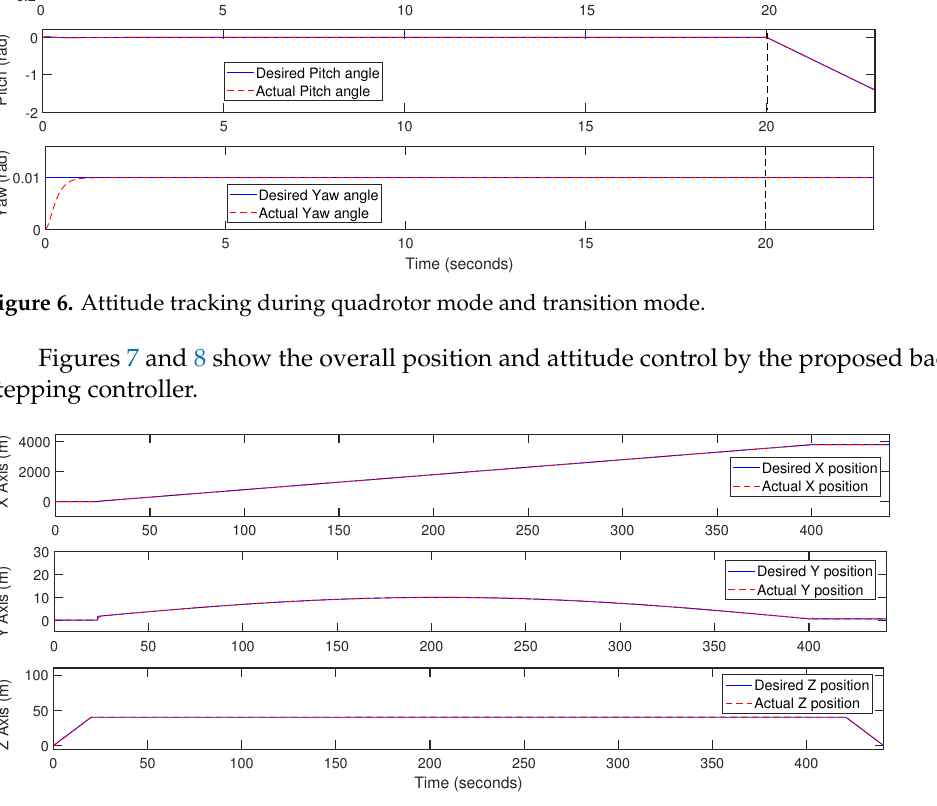
Figure 7. Position tracking by backstepping controller. After the transition, the vehicle is converted to a conventional fixed-wing UAV. For 23 < t < 400 s, the UAV is commanded to travel at 10 m/s velocity in level-flight mode. The trajectory is effectively controlled without altitude drop, and a 10 m/s velocity is maintained. In the period 400 < t < 401 s, the UAV is commanded to rotate about its pitch angle from − 80 ◦ to 0 ◦ , and transits from level-flight mode to quadrotor mode where there is no position change in x and y direction. For 401 < t < 421 s, UAV commanded to hold altitude at 40 m and 421 < t < 441 s it commanded to activate landing phase. As shown in Figures 7 and 8, The backstepping controller tracks the desired trajectory, and the simulation results validate the controller’s